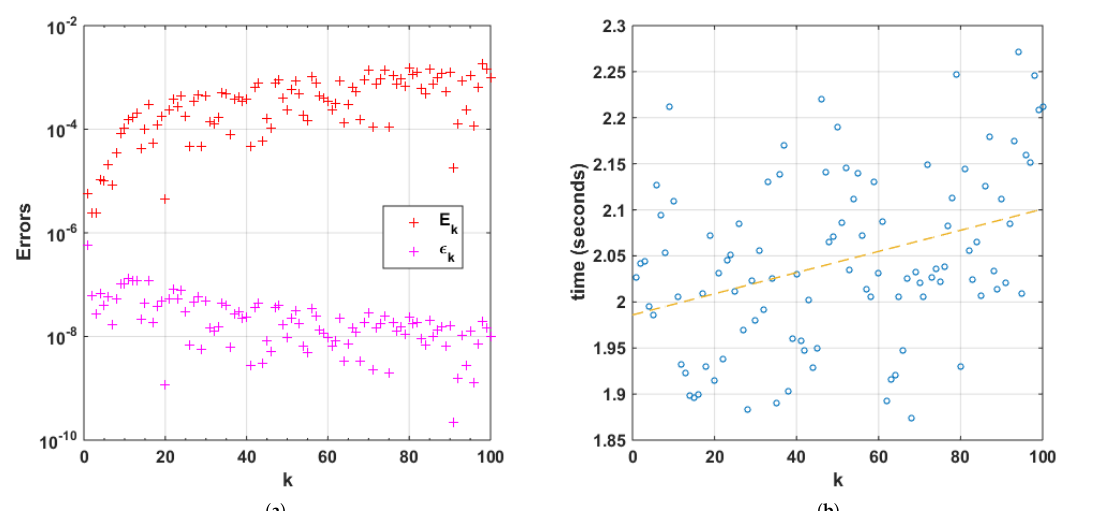
Figure 1. ( a ) Log absolute error (red) and log relative error (magenta); and ( b ) computing time (in seconds) (blue circles) and linear trend line (orange dashed line) for the first 100 eigenvalues using Magnus method for the problem − y (cid:48)(cid:48) = λ y ,0 < x < 1, y ( 0 ) = y ( 1 ) =